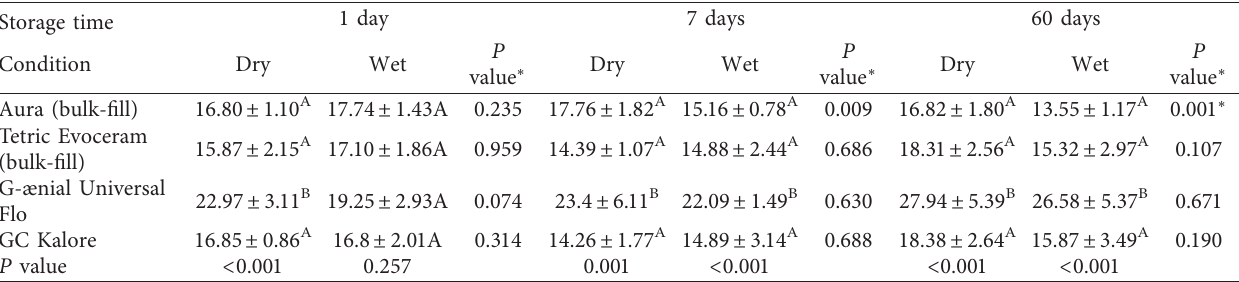
Table 2: Comparison of mean ± SD values of fracture toughness ( K t -test.